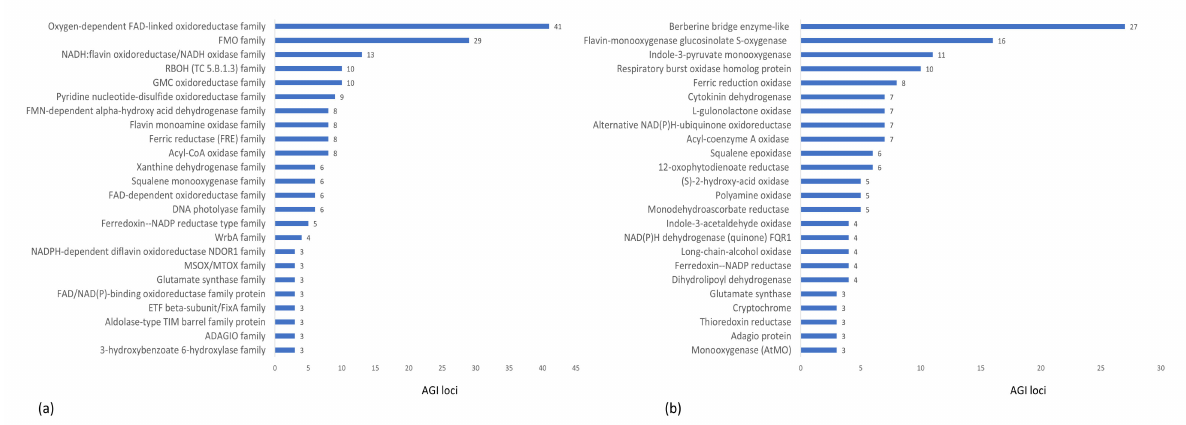
Figure 3. ( a ) Accumulation of protein families and ( b ) their subclasses among the flavoproteome in A. thaliana . Chart ( a ) and ( b ) are based on the AGI locus numbers from Table S1. Protein families and subclasses with an accumulation of less than three AGI loci have not been considered in these